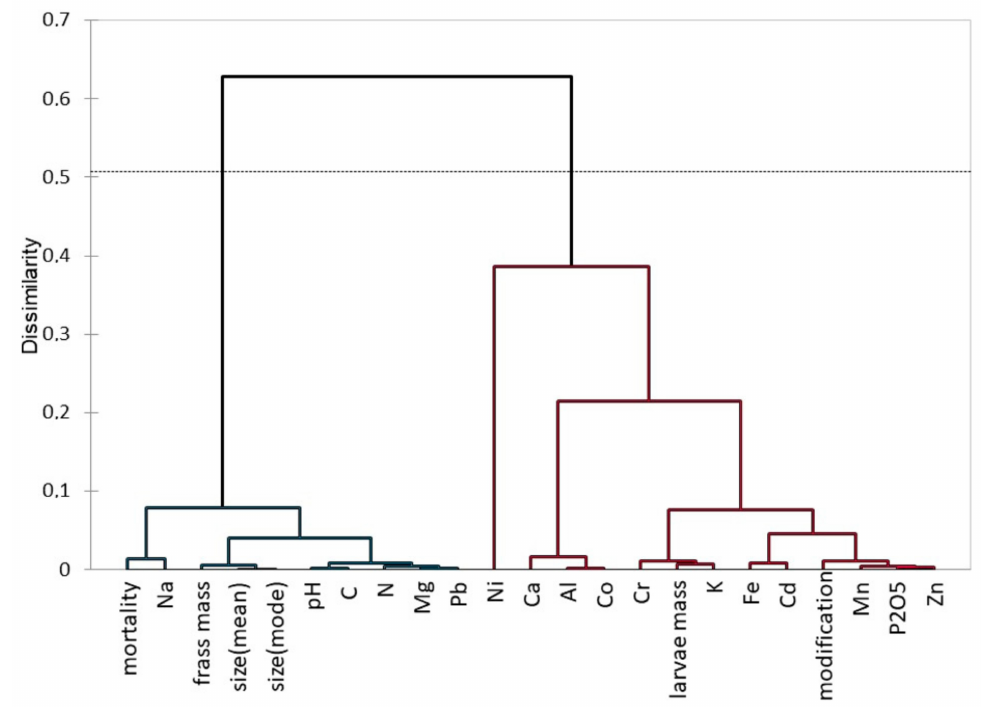
Figure 10. Dendogram of AHC showing dissimilarity between